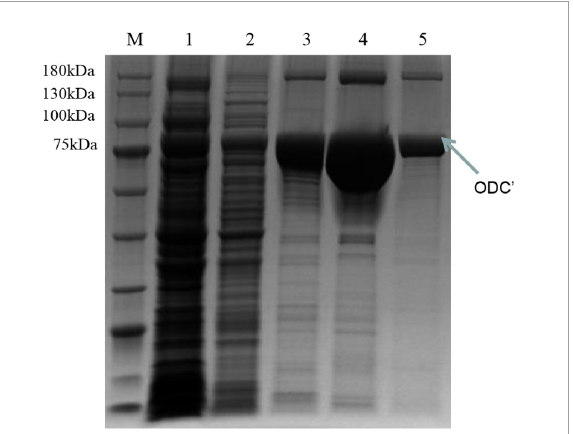
FIGURE7 SDS-PAGE verification of the different concentrations of imidazole eluents after the inducement of at 20 ◦ C for 14 h with the final concentration IPTG of 0.05 mM. M represented the protein marker (180 kDa). Lane 1 represented the supernatant after breaking by a low-temperature high-pressure cell crusher. Lanes 2–5 represented the eluents of different concentrations of imidazole (20 mM, 50 mM, 100 mM, 200 mM),